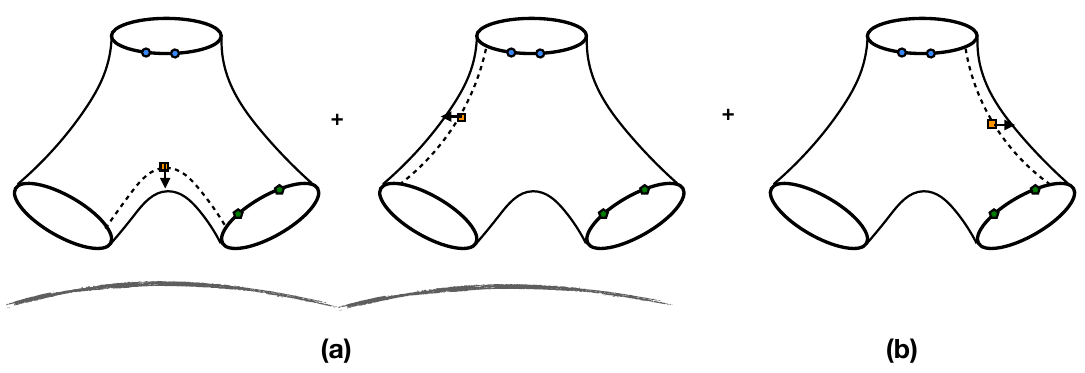
Figure 13 . For two non-BPS operators there is one mirror edge that is distinct from the other two. It turns out that up to two loops only the finite size corrections (a) contribute while the finite size correction (b) will only starts at three loop